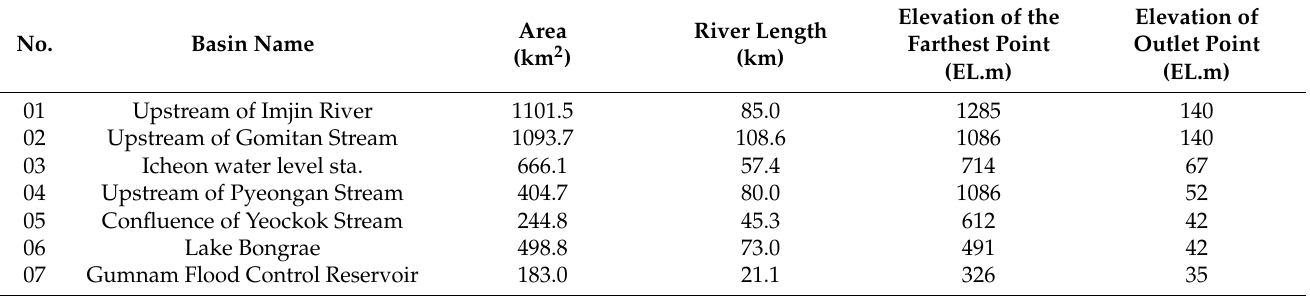
Table 3. The sub-basin characteristics in the study area.